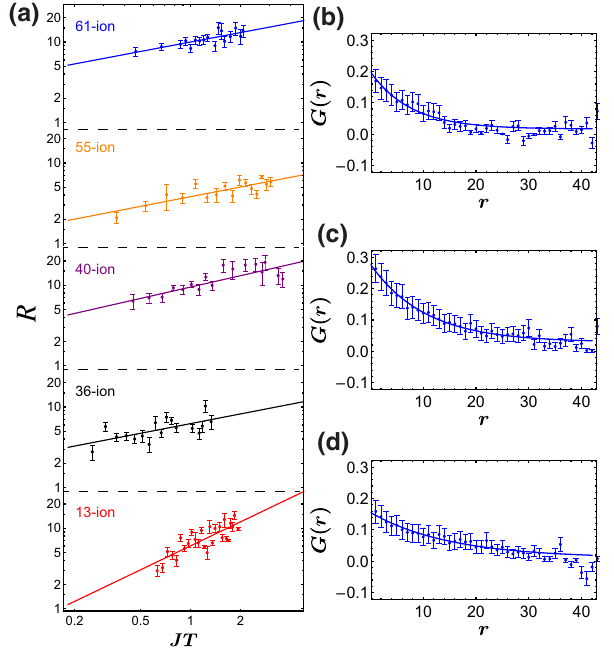
FIG. 3. Quantum Kibble-Zurek mechanism and scaling. We initialize a polarized state | ↑ y · · · ↑ y (cid:4) along the transverse field and quench the field to zero following an exponential path B ( t ) = B 0 [exp ( − t /τ) − exp ( − T /τ) ] where τ = T / 5. To make the polarized state close to the initial ground state, we set a strong initial field B 0 = 42.5 | J 0 | . For each total evolution time T , we measure the two-spin correlation (cid:11) σ i and further extract the correlation length R on the ion chain through an exponential fitting. (See the right panels for T = 0.875 , 1.75 , and 2.75 ms as some typical results at N = 61. The reason for the different magnitudes of the correlation is discussed in Appendix B.) We summarize the results for vari- ous ion numbers N versus the dimensionless quench time | J 0 | T in the left panel as semilog plots. For N = { 13, 36, 40, 55, 61 } , the slopes are { 0.99 ± 0.07, 0.40 ± 0.08, 0.47 ± 0.08, 0.40 ± 0.06, 0.39 ± 0.09 } , respectively. Except for the smallest ion num- ber N = 13 where the finite-size effect can be significant, we get consistent slopes as an estimation of the critical exponent μ ≈